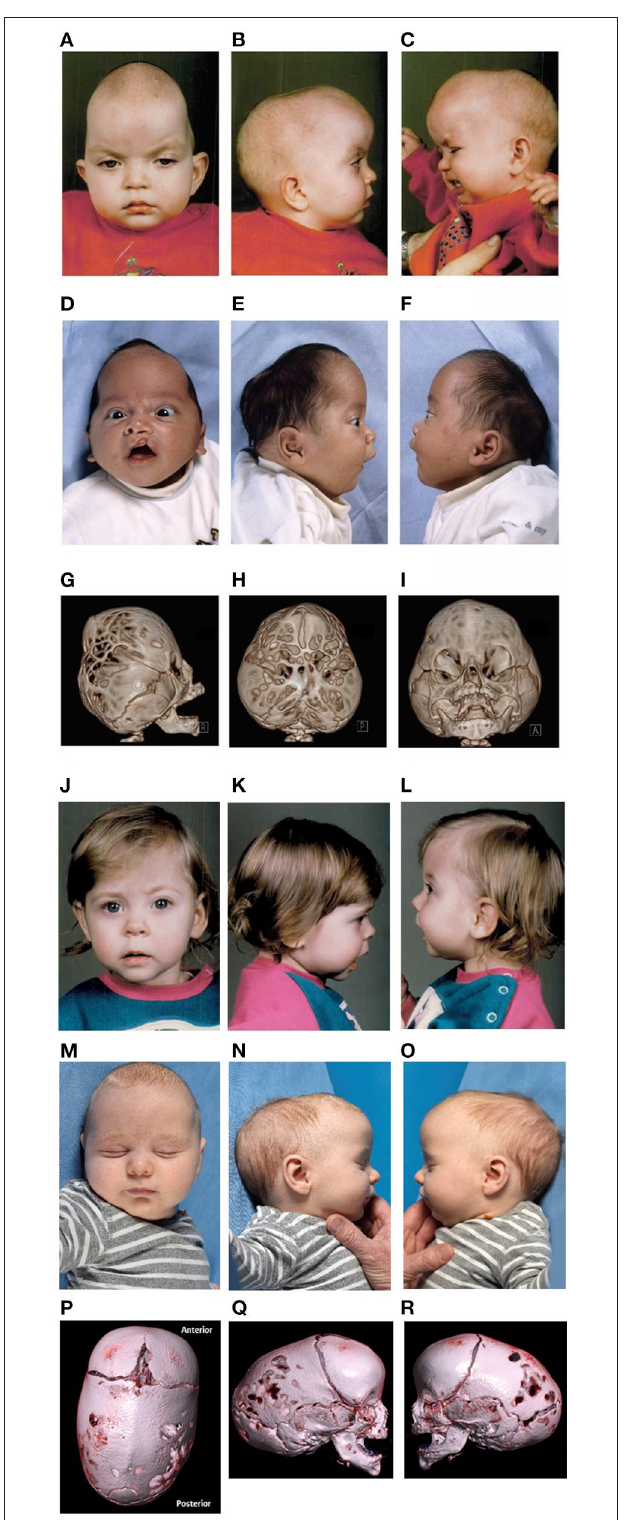
FIGURE 1 | Clinical features. Photos published with consent. (A–C) Pre-operative features of patient A at the age of 14 months. Historic